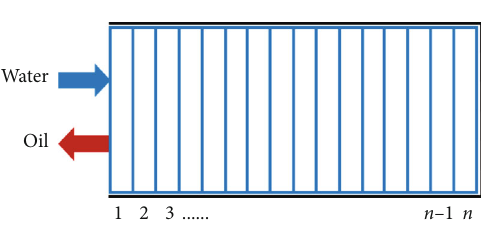
Figure 3: Five-point di ff erence grid.